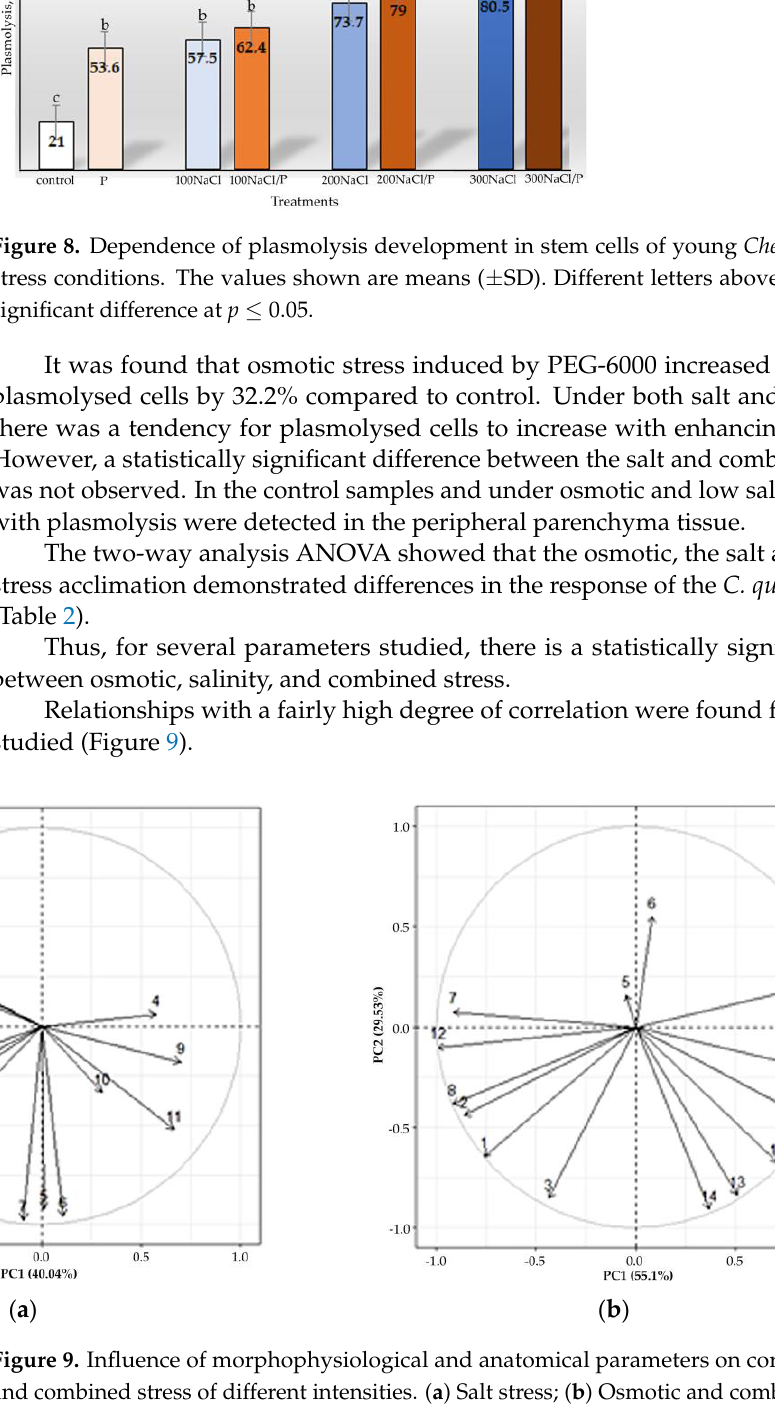
growth; 2, Water content (from raw biomass); 3, Leaf biomass; 4, Na + ion content; 5, K + ion content; 6, K + /Na + ratio; 7, Thickness of stem parenchyma; 8, Area of stem xylem; 9, Percentage of plasmolysis in cells; 10, Thickness of adaxial leaf epidermis; 11, Thickness of abaxial leaf epidermis; 12, Thickness of mesophyll; 13, Thickness of central leaf vein; 14, Diameter of central leaf vascular bundle.